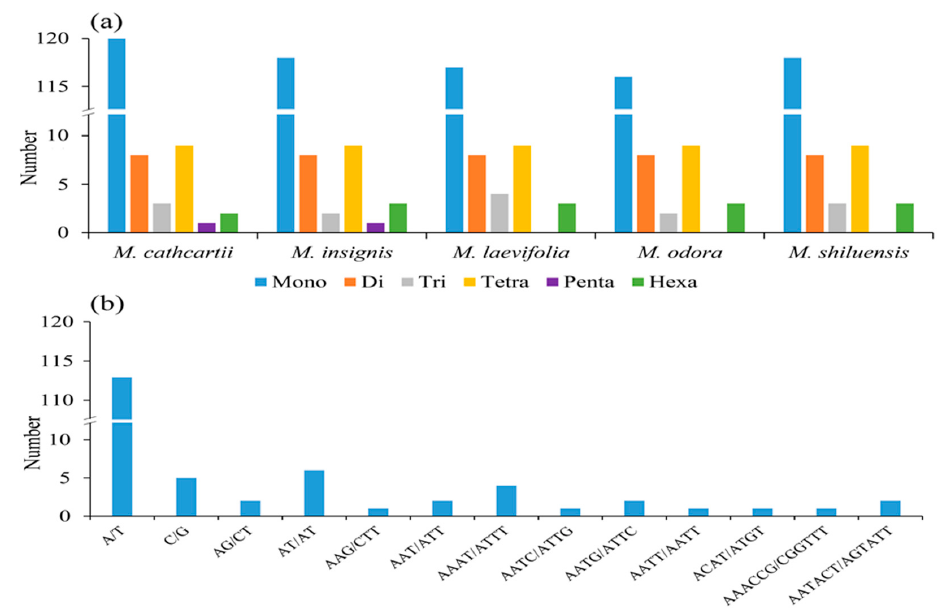
Figure 2. Comparison of repeats among five Magnoliaceae species: Michelia shiluensis , Michelia odora , Magnolia laevifolia , Magnolia insignis , and Magnolia cathcartii . (F: Forward; R: Reverse; C: Complement; and P: Palindromic).